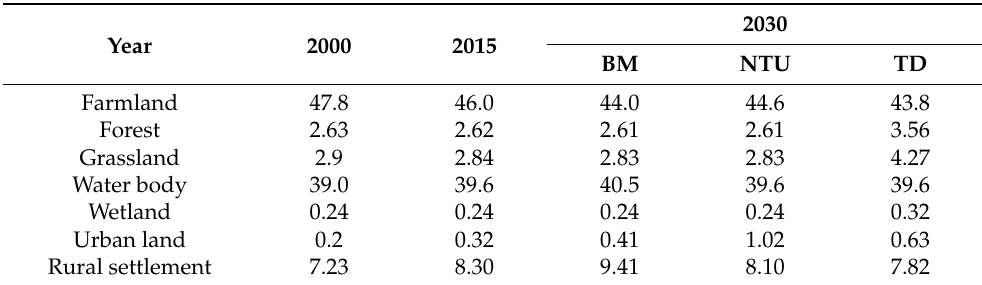
Table 2. Area ratio of different land use types in Chaohu Peninsula in 2000 and 2015 and the predicted area ratio in 2030 under different scenarios (%).